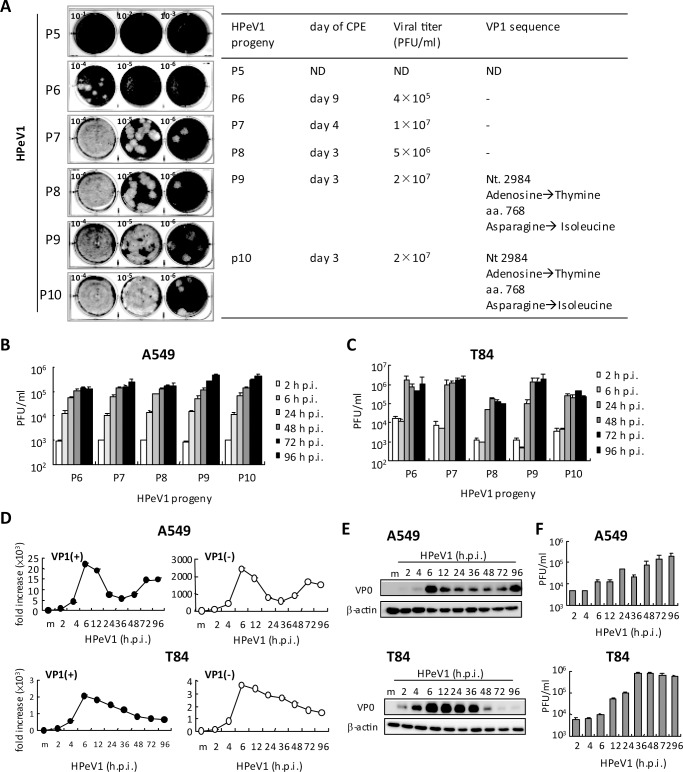
HPeV1 propagation and replication analysis.
(A) Left panel, plaque-forming assay of HPeV1 titration of
P5-P10 progeny. Right panel, cytopathic effect (CPE) formation, HPeV1
viral titer, and the results of VP1 sequence for each progeny. P5, ND:
not determined; P6-P8, sequence no change; P9-P10, the point nucleotide
and amino acid mutation are indicated. (B) A549 cells and
(C) T84 cells were infected with each progeny at MOI =
1; plaque-forming assay of virus production kinetics in culture medium
harvested at indicated times. (D) RT-qPCR analysis of mRNA
level of HPeV1 structure-protein (VP1) positive sense (+) and negative
sense (-) in A549 cells (2×105, upper panels) and T84
cells (2×105, lower panels) infected with HPeV1 (MOI =
1). Data are mean±SD. (E) Immunoblotting of VP0
viral protein and loading control, β-actin, in A549 cells
(2×105, upper panels) and T84 cells
(2×105, lower panels) infected with HPeV1 (MOI =
1) as indicated. (F) A549 cells (2×105,
upper panel) and T84 cells (2×105, lower panel) were
infected with HPeV1 (MOI = 1); plaque-forming assay of virus production
in culture supernatant at the indicated times. Data are
mean±SD.